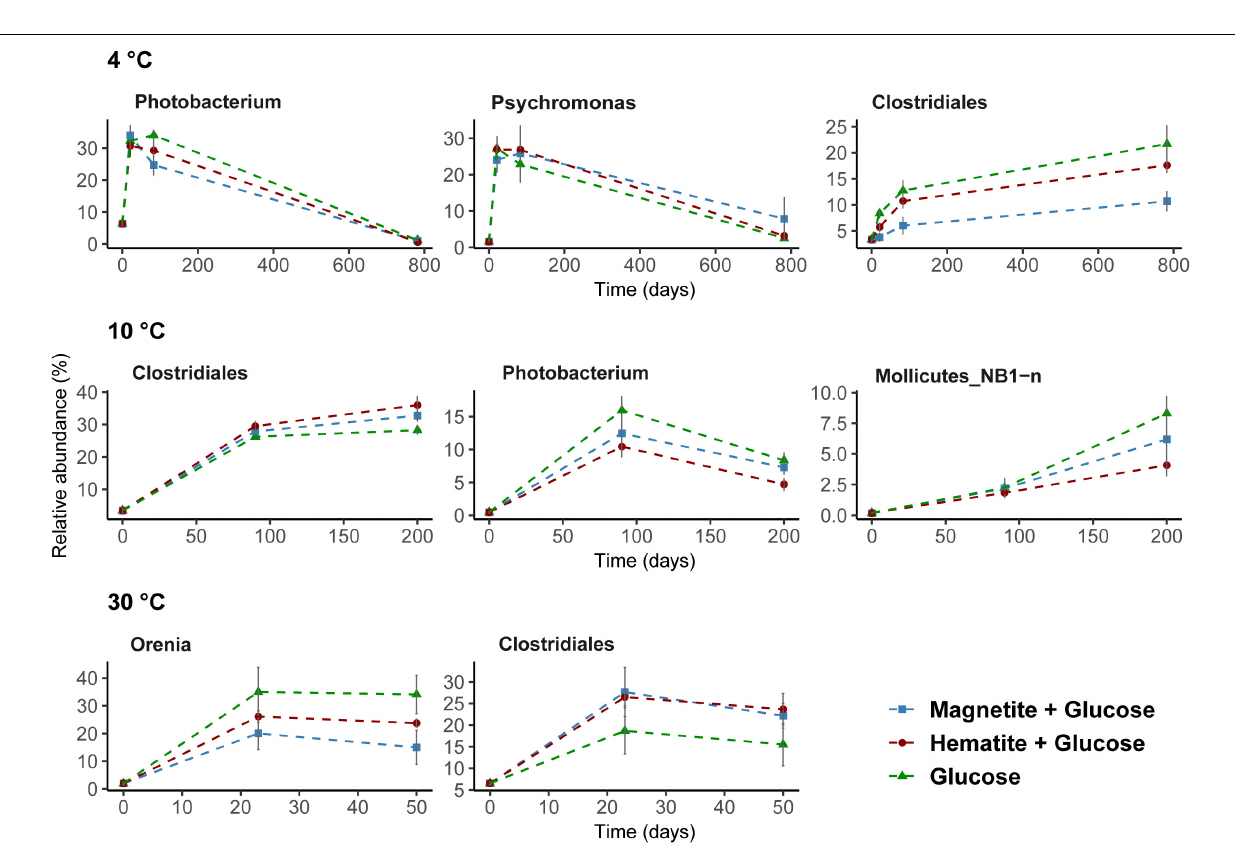
Frontiers in Microbiology |